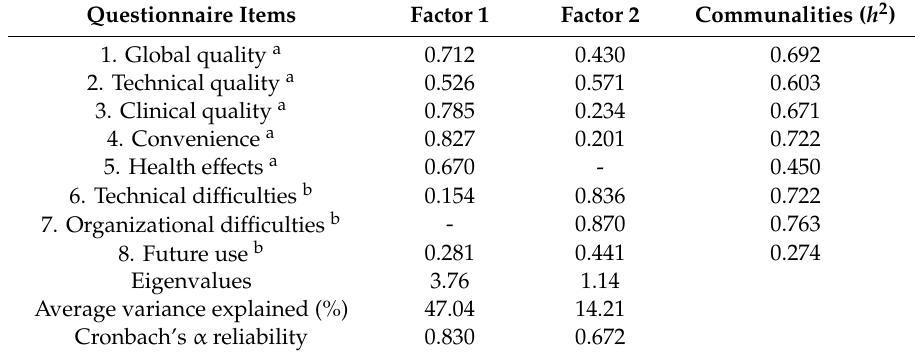
Table 2. Exploratory factor analysis (EFA): data on commonalities of items, item loadings in Factor 1 and Factor 2.